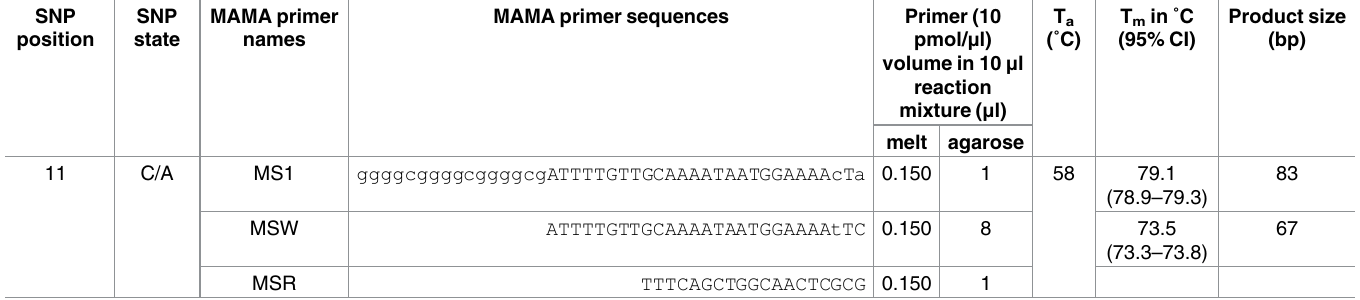
Table 2. SNP locations in the HIT family protein coding gene, SNP state, primer sequences, primer volumes, annealing temperature (T a ), melting temperatures (T m ) and PCR product sizes for the MS1 melt- and